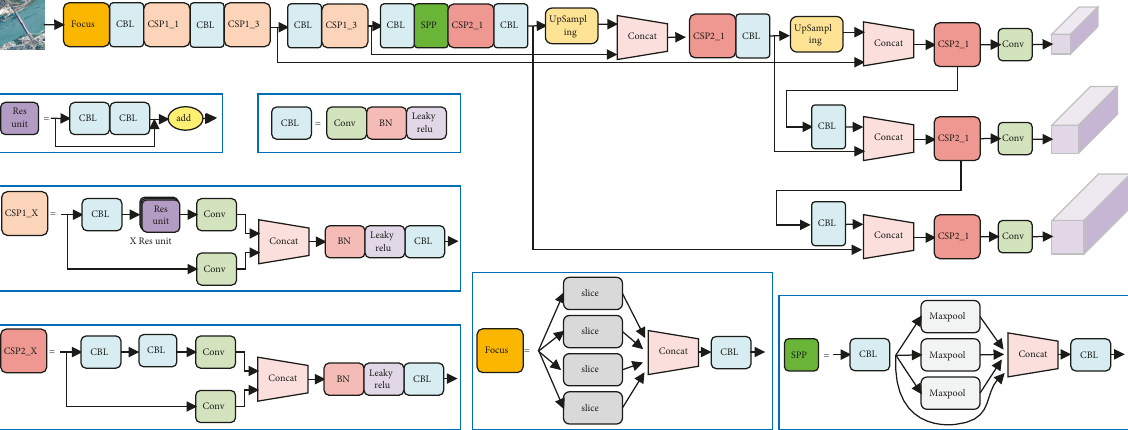
Figure 4: The architecture of YOLOv5